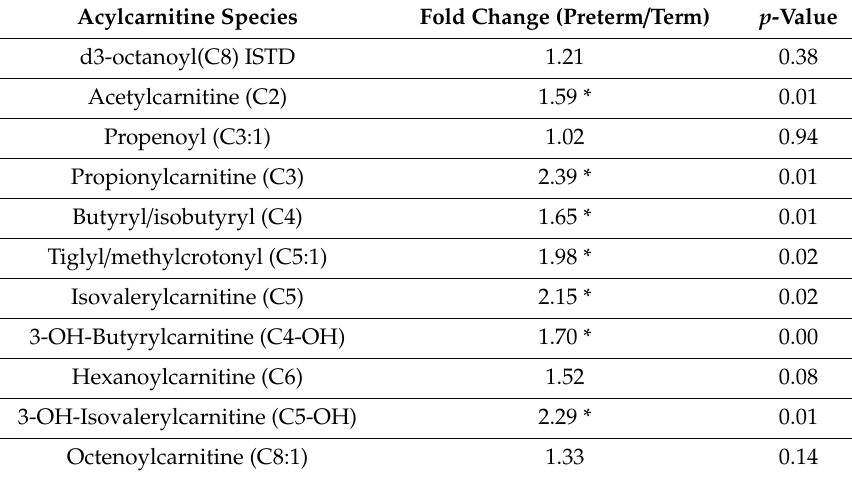
Table 7. Changes in acyl carnitine levels found via confirmatory assay in human preterm